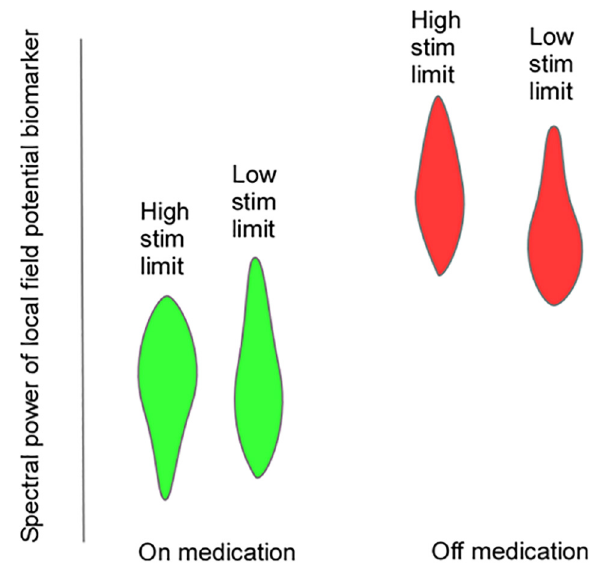
FIGURE 6 | Hypothetical violin plots showing distribution of a putative LFP biomarker that would be useful for “slow” aDBS. The biomarker distributions distinguish on-medication (green) and off-medication (red) states at both upper and lower stimulation amplitude limits.